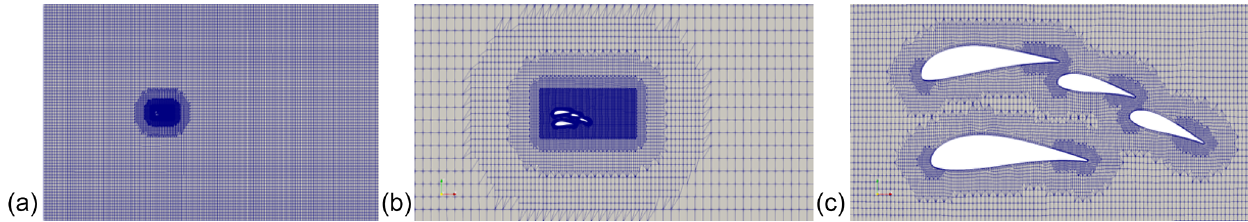
Figure 3. (a) CFD domain. (b) Refinement zone around the profile. (c) Refinement layers around the elements.